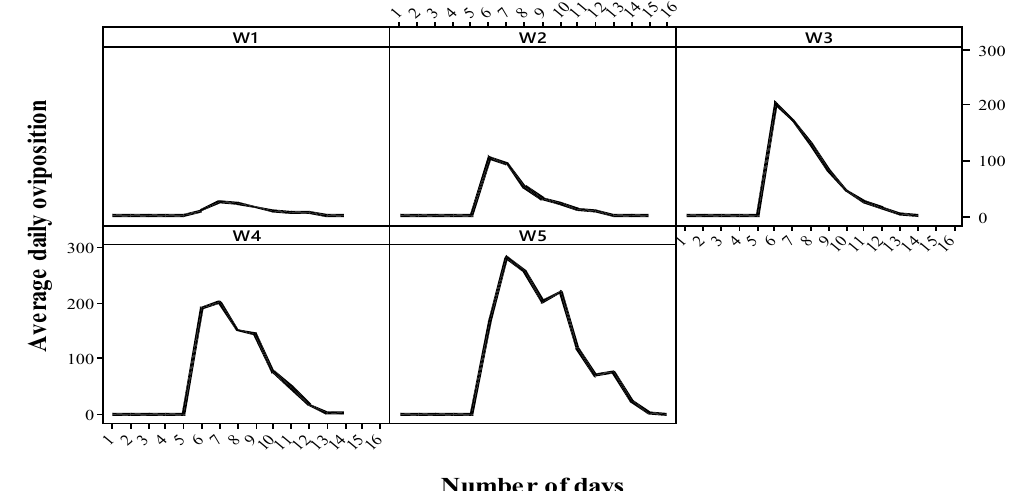
Figure 1: Oviposition patterns of R. microplus females under four weight categories (W1 to W5).